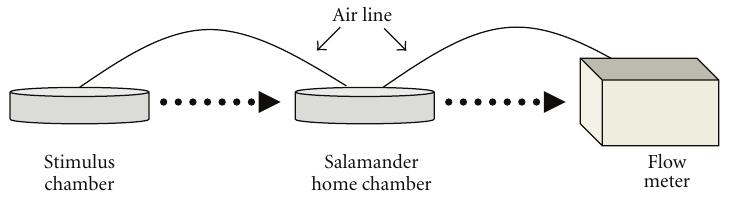
Figure 1: Diagram of the testing apparatus used to test behavioral responses of salamanders to airborne cues in Experiment 2 (diagram modified from Windel 2005). Salamanders occupied their home chambers which were connected by air line to stimulus chambers containing diluted armadillo feces, deer feces, or blank water; air was pumped from the stimulus chamber through the salamander’s chamber via the flow meter. Dotted arrows indicate direction of flow.